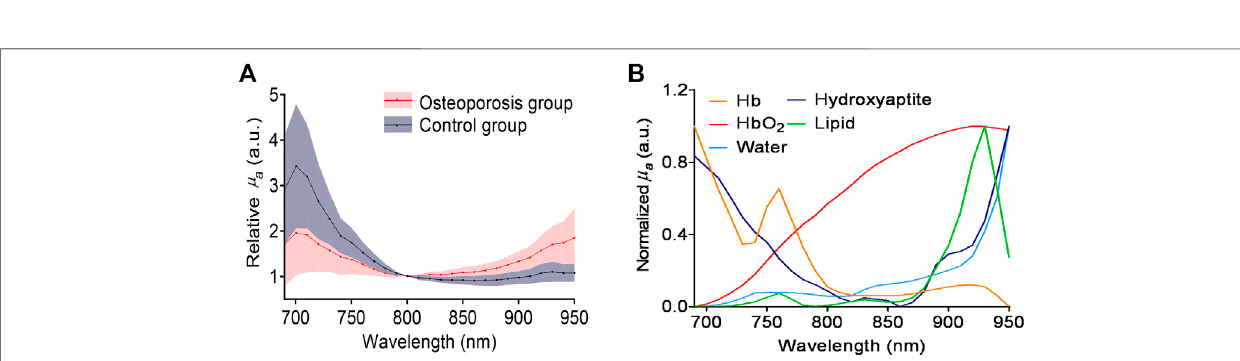
Frontiers in Physics |